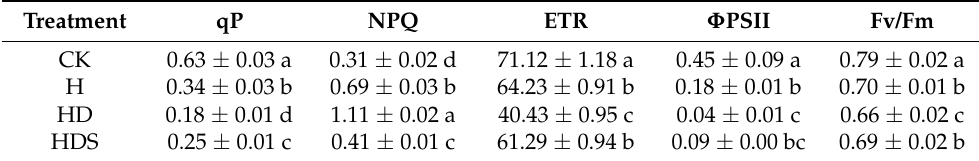
Table 3. Effects of exogenous spermidine and D-arg on chlorophyll fluorescence parameters of lettuce under high-temperature